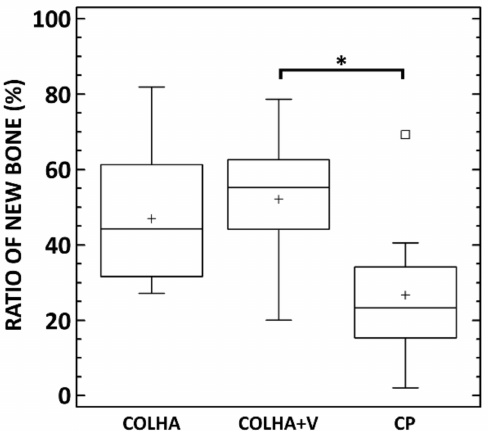
Figure 10. Ratio of new bone integrated into the surface of the implanted titanium samples with col- lagen/hydroxyapatite electrospun layers with (COLHA+V) and without (COLHA) vancomycin and the control samples without an electrospun layer (CP). * Denotes statistically significant differences (0.05, Kruskal–Wallis test with the Bonferroni